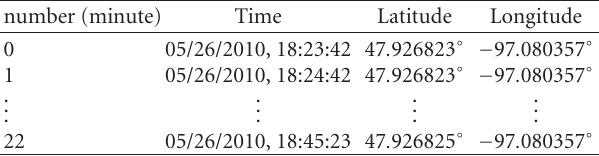
Table 3: An example of detail information of a